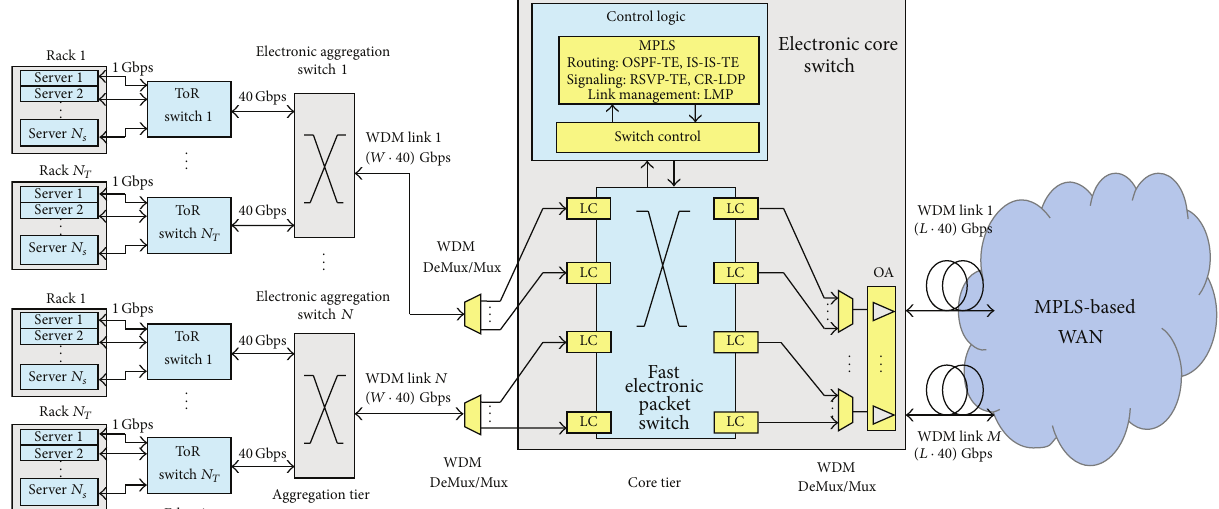
Figure 1: Architecture of a data center employing an optical ptp interconnection network. ToR: top of the rack, OA: optical amplifiers.